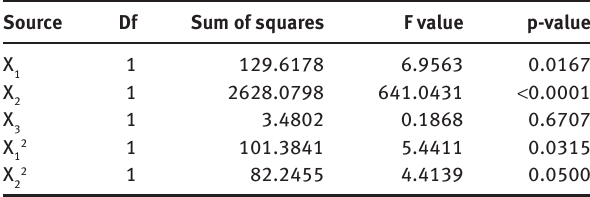
Table 4: Significance test for the regression coefficients.